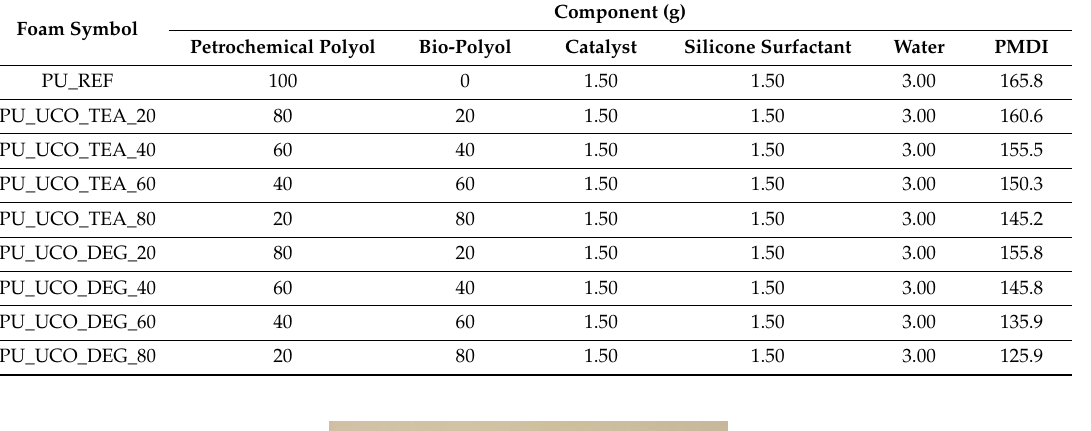
Table 2. Formulations of foam materials obtained with di ff erent amounts of the bio-polyols. Foam Symbol